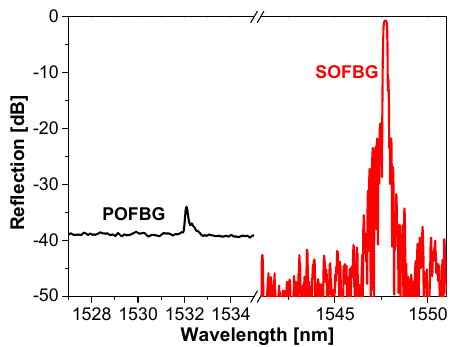
Figure 2. Reflection spectra of typical POFBG and SOFBG at 25 °C.